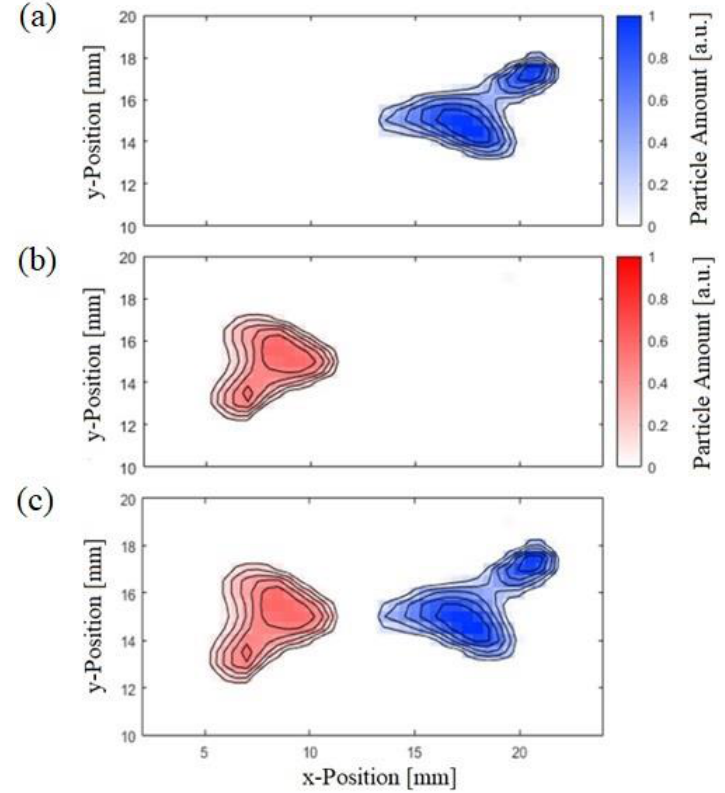
Figure 7. Reconstructed images for measured signal, ( a ) CT100 MNP and ( b ) ARA100 MNP type, ( c ) both MNP types simultaneously. ( c ) both MNP types